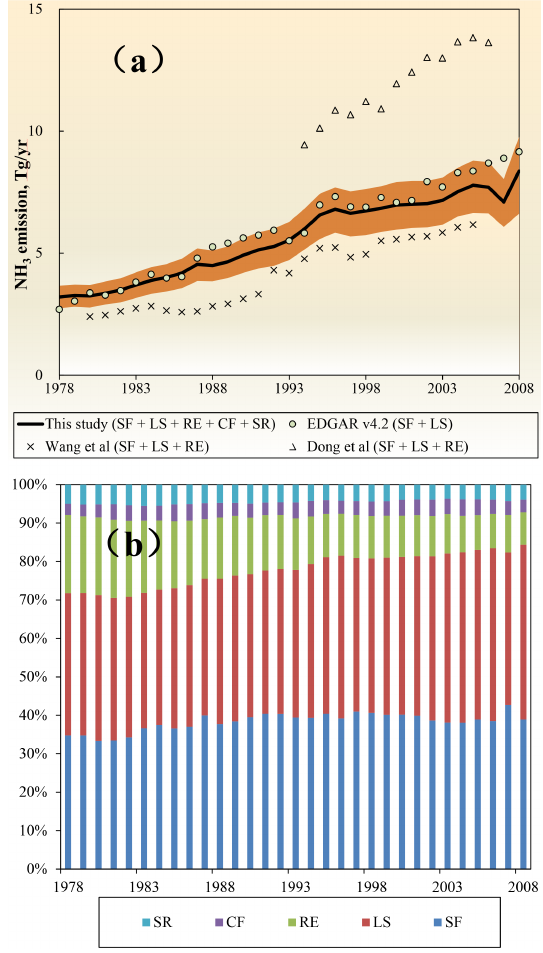
Figure 5. Temporal trend for agricultural fertilizer NH 3 emissions for China (a) and sector contributions between 1978 and 2008 (b) . The emission estimate and the uncertainty are provided as a median value (black curve) and the R 50 (shaded area, for total emissions) derived from a Monte Carlo simulation. Note: SF refers to synthetic fertilizer application; LS refers to livestock manure spreading; RE refers to rural excrement; CF refers to cake fertilizer; SR refers to straw